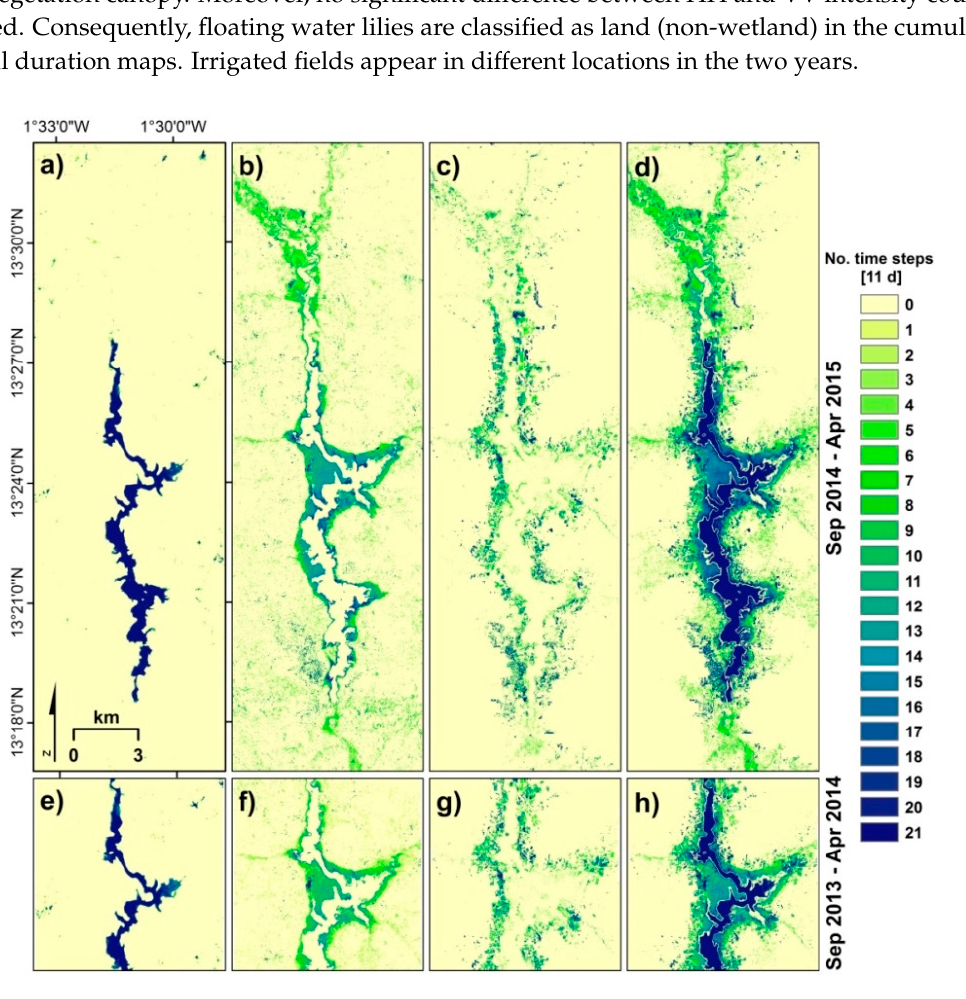
Figure 10. Cumulative season duration areas of 21 time steps of the year 2014–2015 for ( a ) open water; ( b ) flooded/floating vegetation; ( c ) irrigated fields; and ( d ) wetland, and ( e – h ) selected focus region for the year 2013–2014 below.